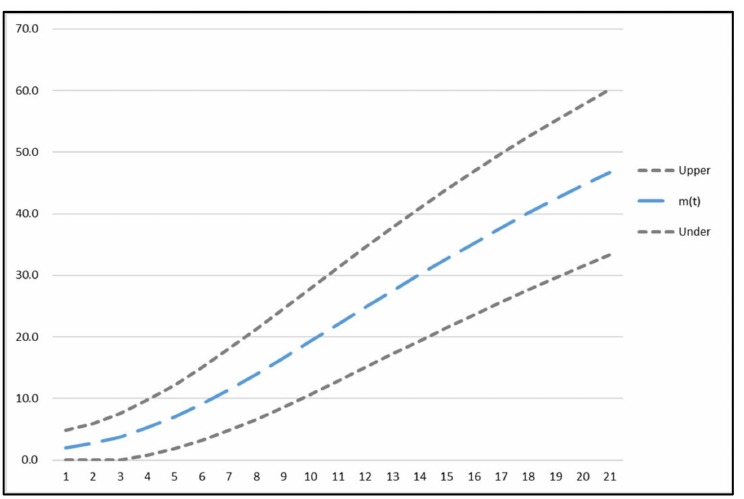
Figure 3. Confidence intervals (95%) of dataset